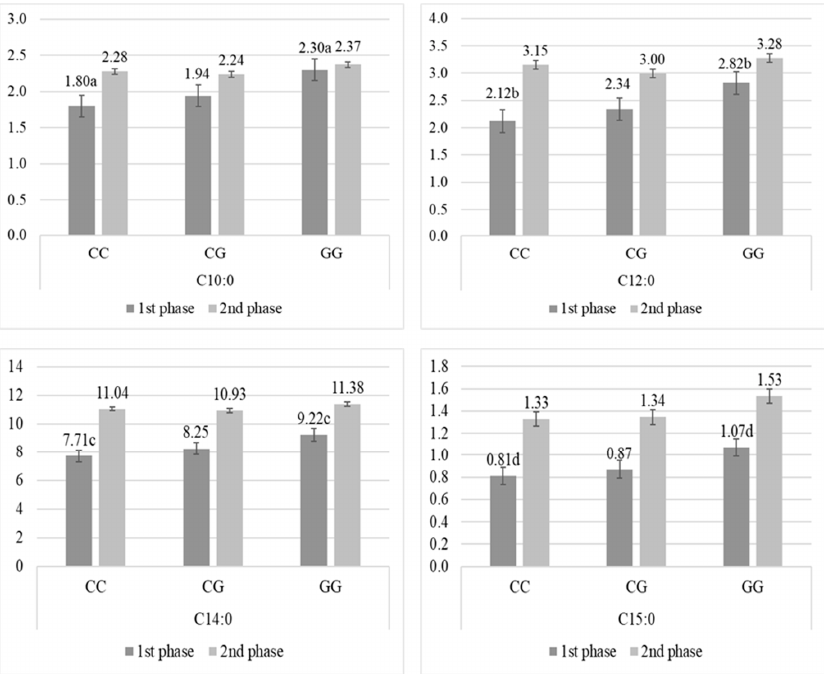
Figure 1. Percentage (mean ± SE) of C10:0, C12:0, C14:0, and C15:0 fatty acids in milk from Polish Holstein-Frisian cows during first and second phase of lactation depending on AJ312201.1g.1488C > G (g.1488C > G) single nucleotide polymorphism (SNP) in acetyl-CoA carboxylase α ( ACACA ) gene. a, b, c, d—values differ significantly between polymorphisms within fatty acid ( p < 0.05).